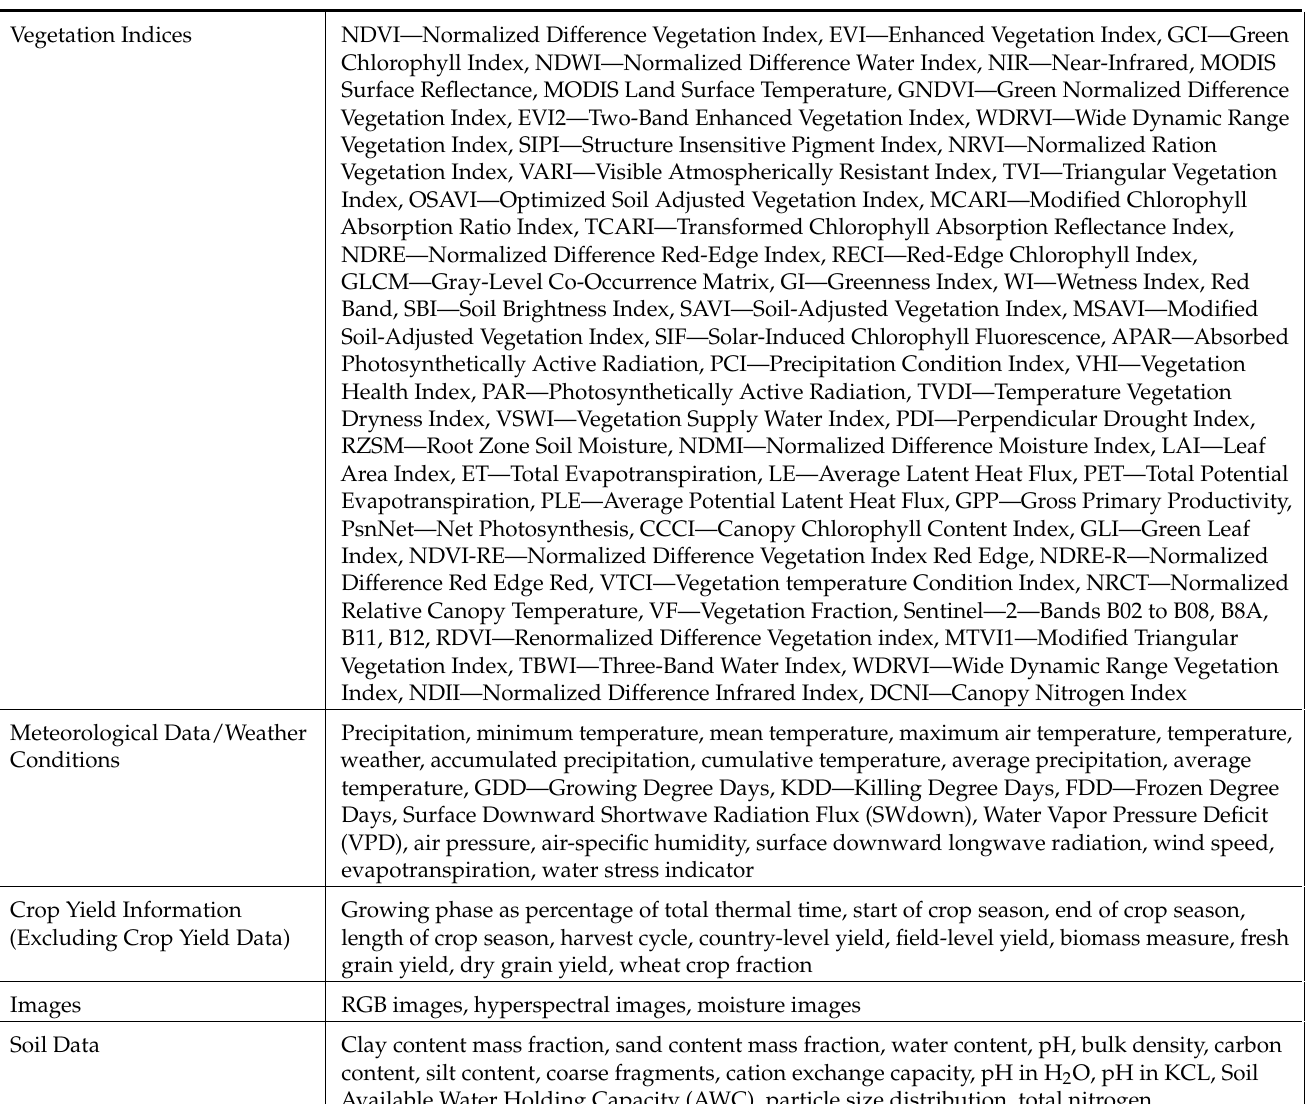
Table 3. Features that influence crop